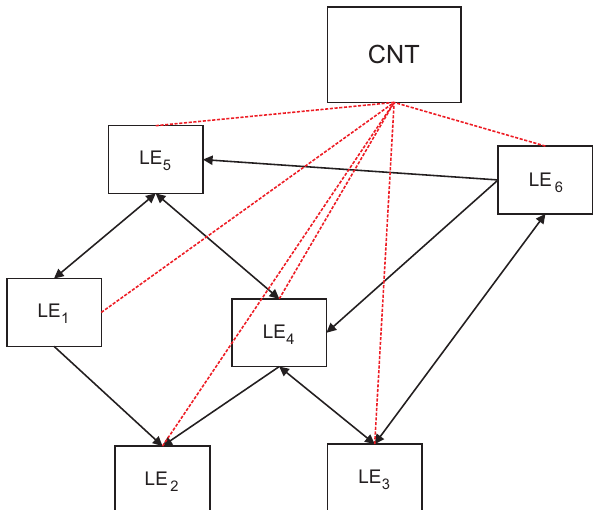
Figure 1. Distributed system of online risk assessment: LE 1 , . . . , LE 6 —local entities delivering services; CNT—Operations Center. Arrows on links show dependencies between services and the information flow during calculations. The red (dotted) lines represent exchange of information between subsequent